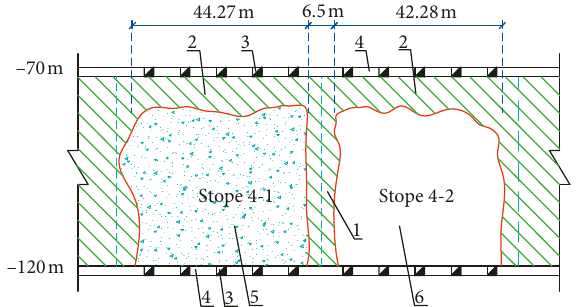
Figure 11: Stope 4-1 and 4-2 layout drawing. 1, intervening pillar; 2, top pillar; 3, loading roadway; 4, stage transport roadway; 5, filling body; 6, goaf.